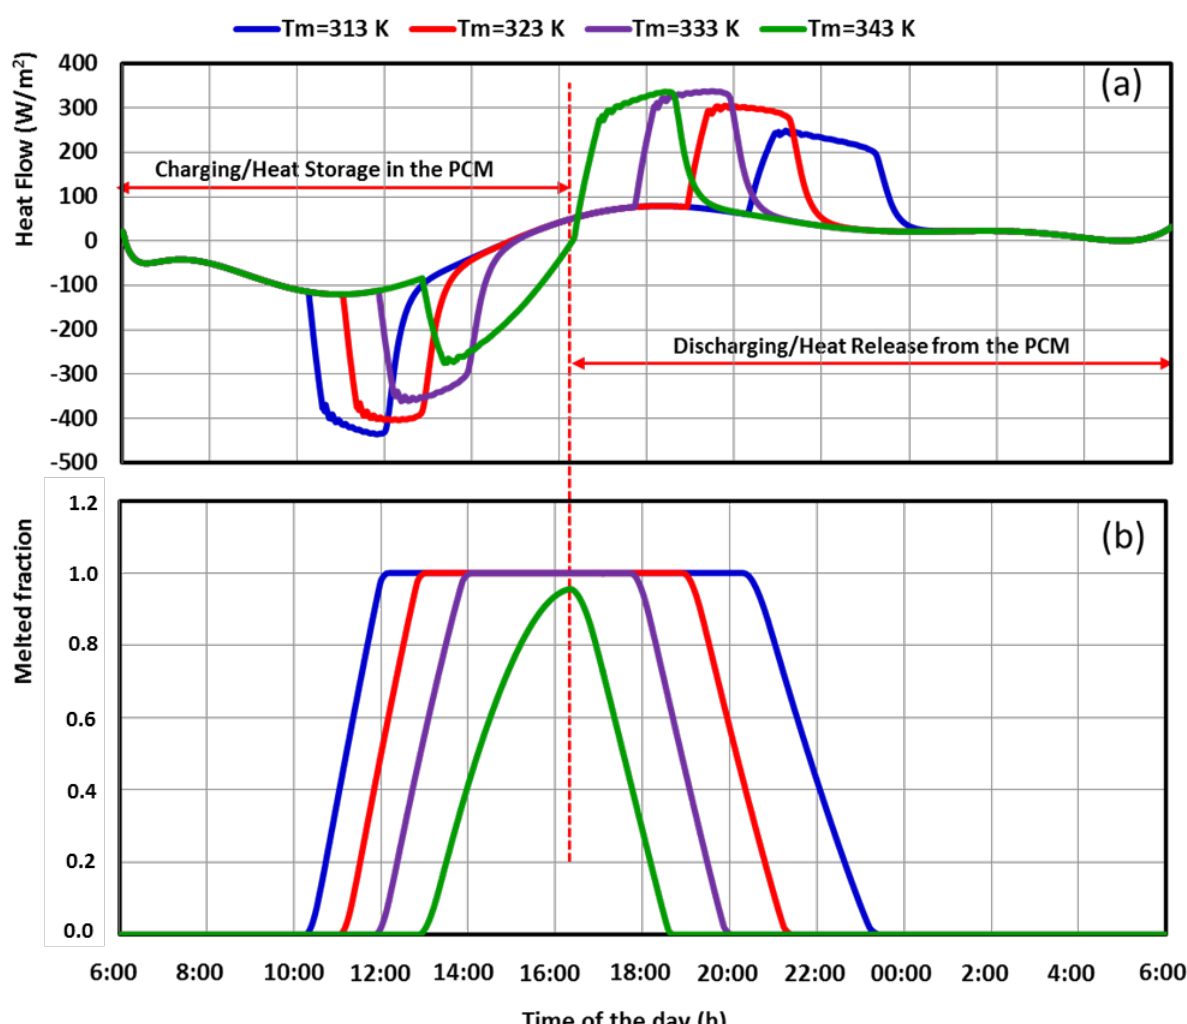
Figure 11. The effect of the PCM melting temperature on: ( a ) the average heat flow transferred to/from PCM; and ( b ) the average PCM melted fraction.